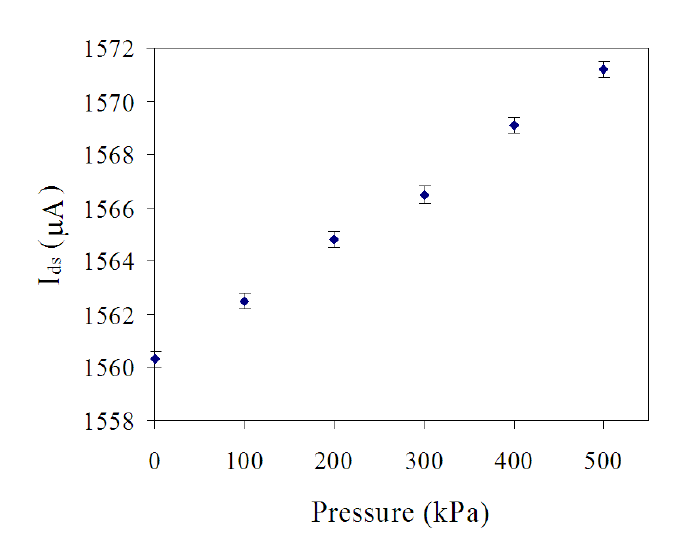
Figure 15. Output current of the FET pressure sensor without circuits.